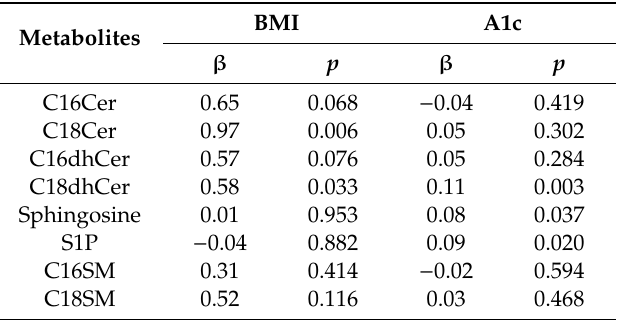
Table 4. Adjusted associations of the changes in sphingolipids with changes in BMI and A1c *. BMI A1c Metabolites β p β p C16Cer 0.65 0.068 − 0.04 0.419 C18Cer 0.97 0.006 0.05 0.302 C16dhCer 0.57 0.076 0.05 0.284 C18dhCer 0.58 0.033 0.003 Sphingosine 0.01 0.953 0.882 0.31 0.52 0.116